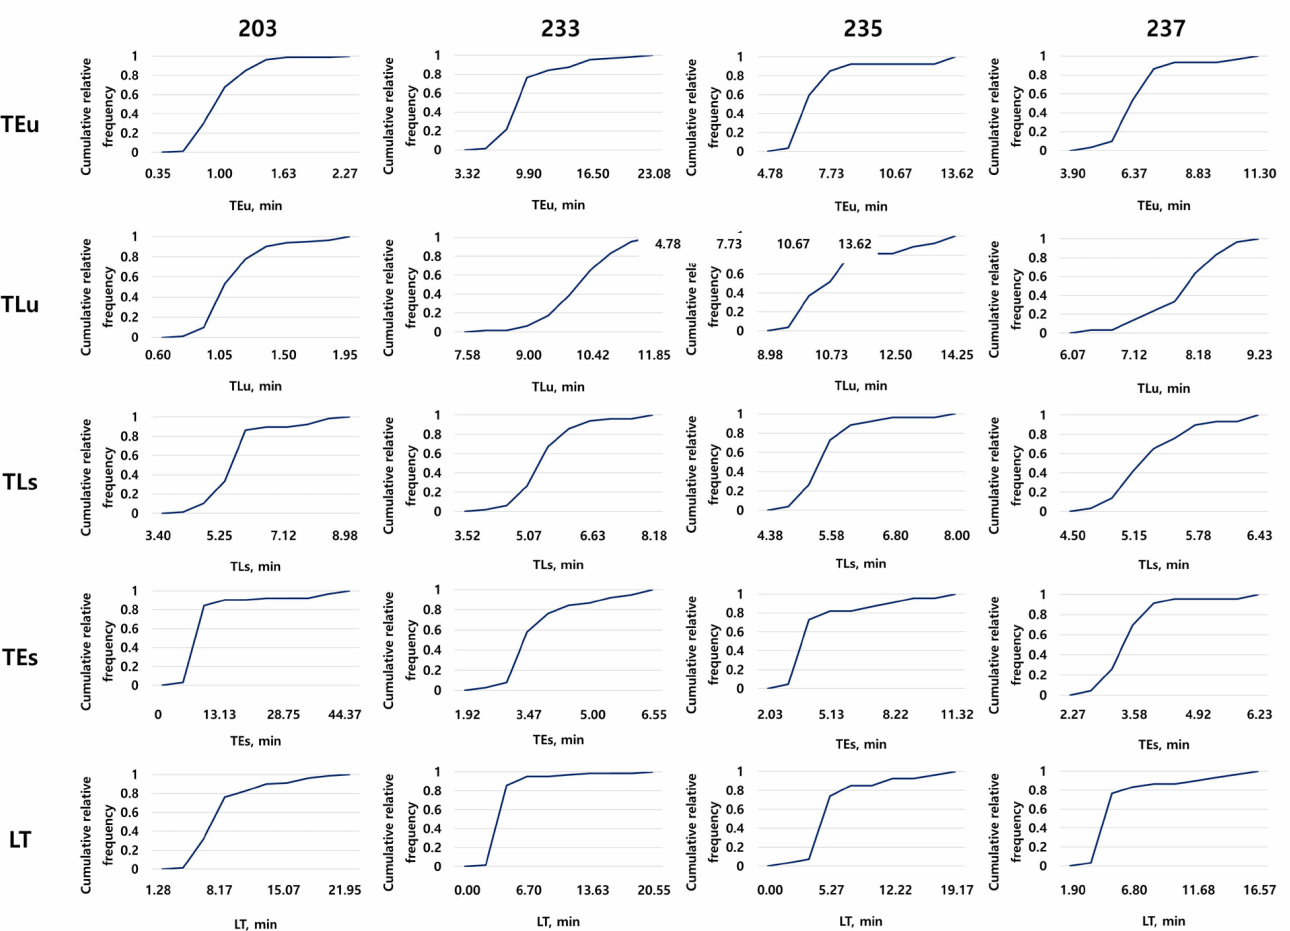
Figure 7. Histogram and cumulative relative frequency graphs of the truck travel time for each loading